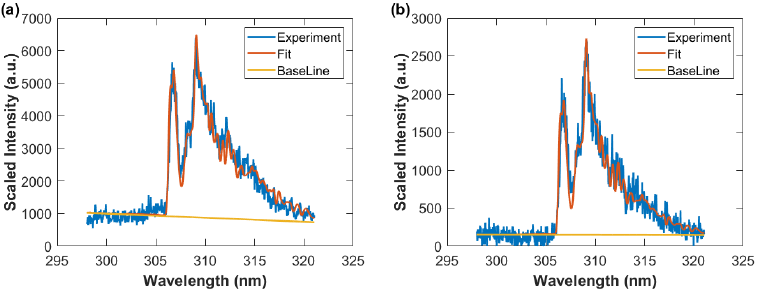
Figure 17. Spectrum fitting results for slit height of 6.43mm and spectral resolution of